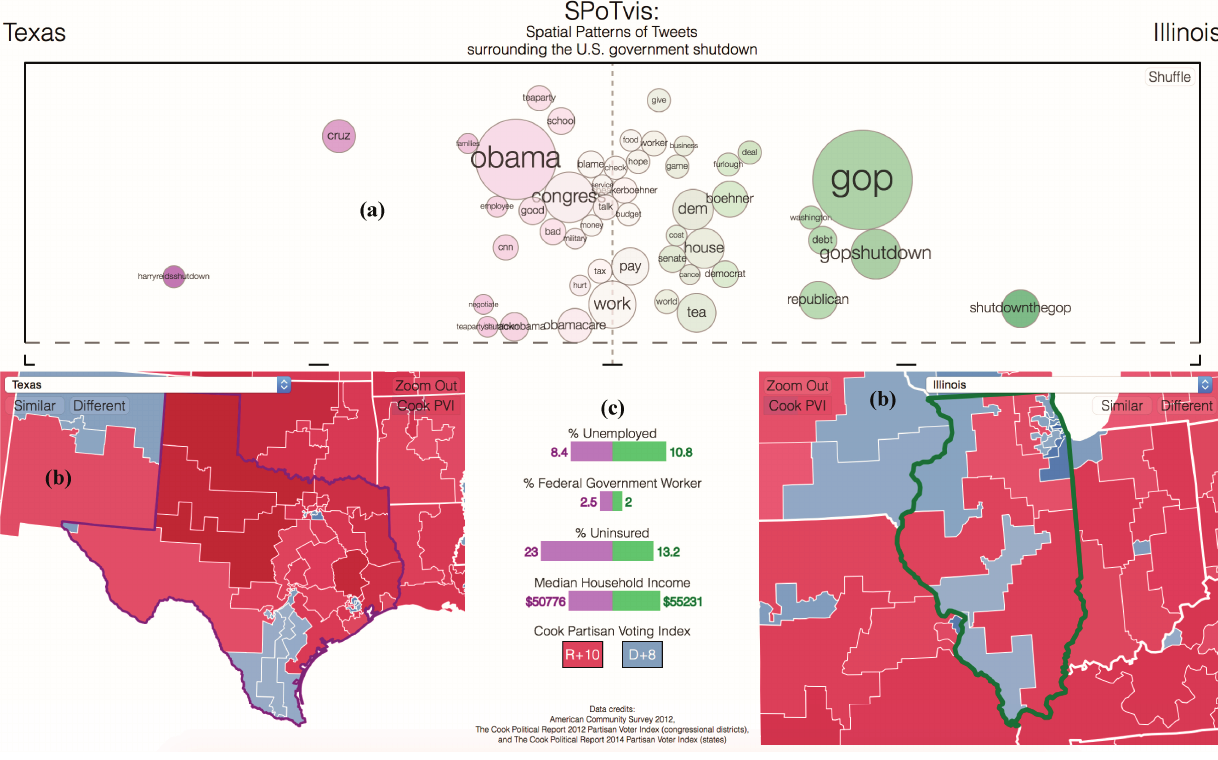
Figure 1. Screenshot of SPoTvis [3]. ( a ) Term polarity plot; ( b ) map views; ( c ) demographic panel. PVI, Partisan Voter